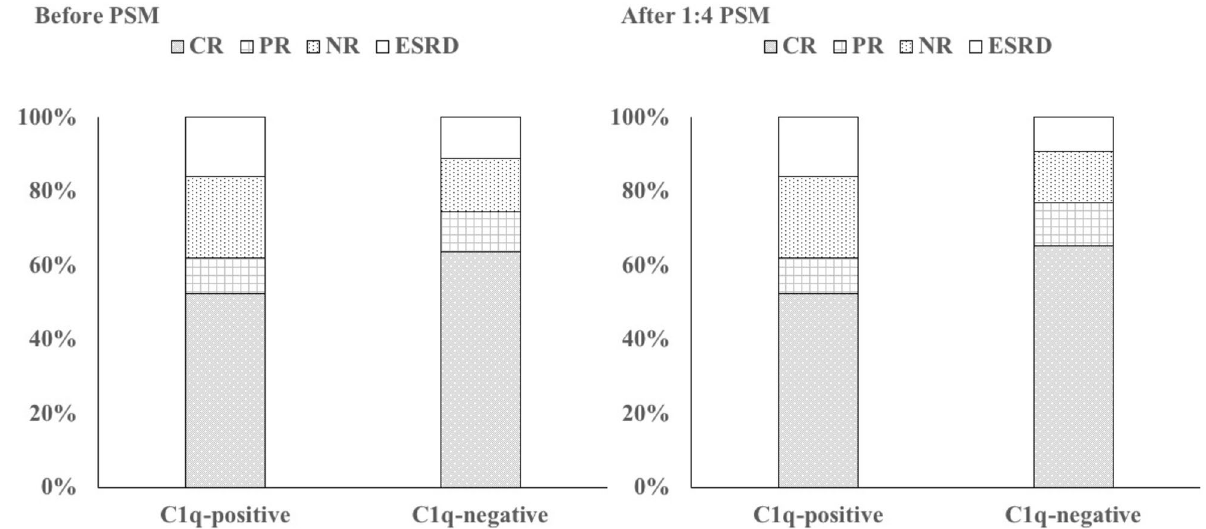
Figure 2. Treatment response and renal outcomes in IgAN patients. CR complete remission, PR partial remission, NR no response, ESRD end stage renal